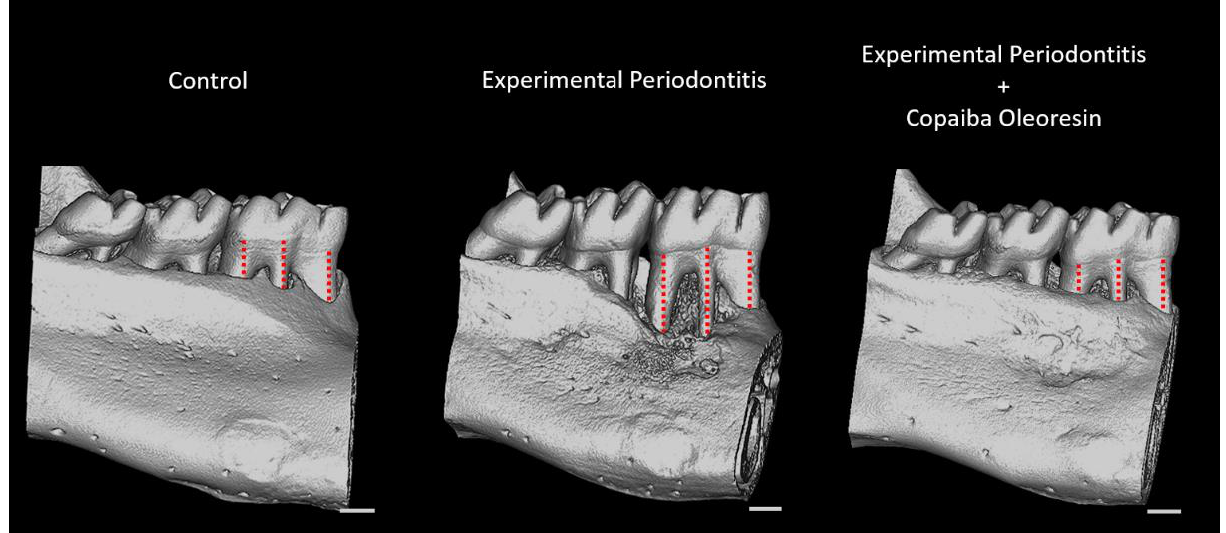
Figure 5. Representative images of the three-dimensional reconstructions of the hemimandible in the control, experimental periodontitis, and experimental periodontitis with copaiba oleoresin administration groups. Red dotted lines indicate the vertical levels analyzed to measure alveolar bone loss. Scale bar = 1 mm.